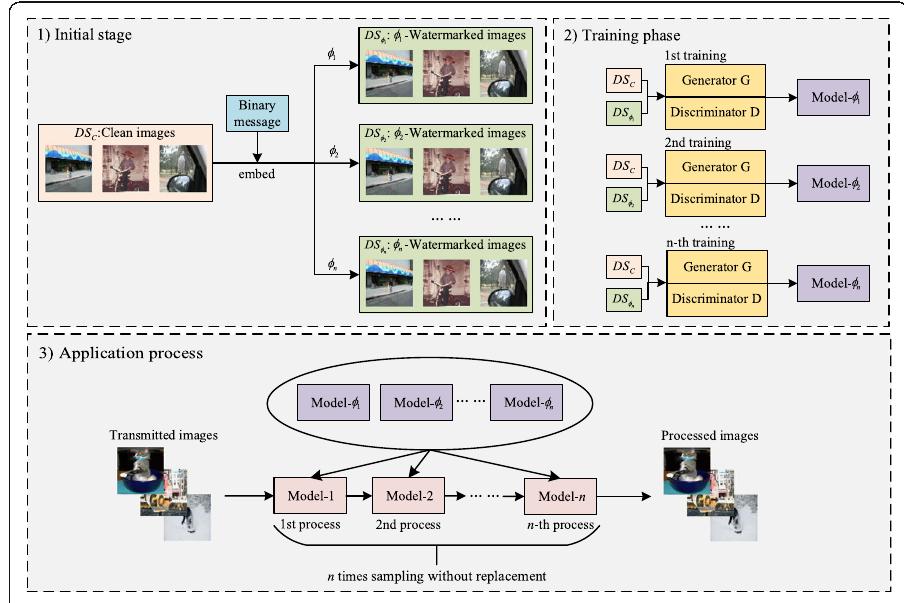
Fig. 1 The framework of the proposed